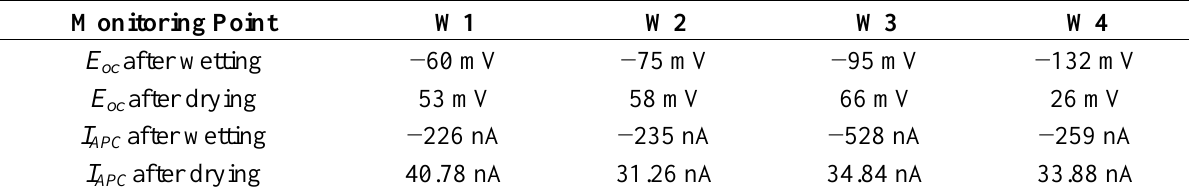
Table 5. Anodic polarization current and potential at monitoring